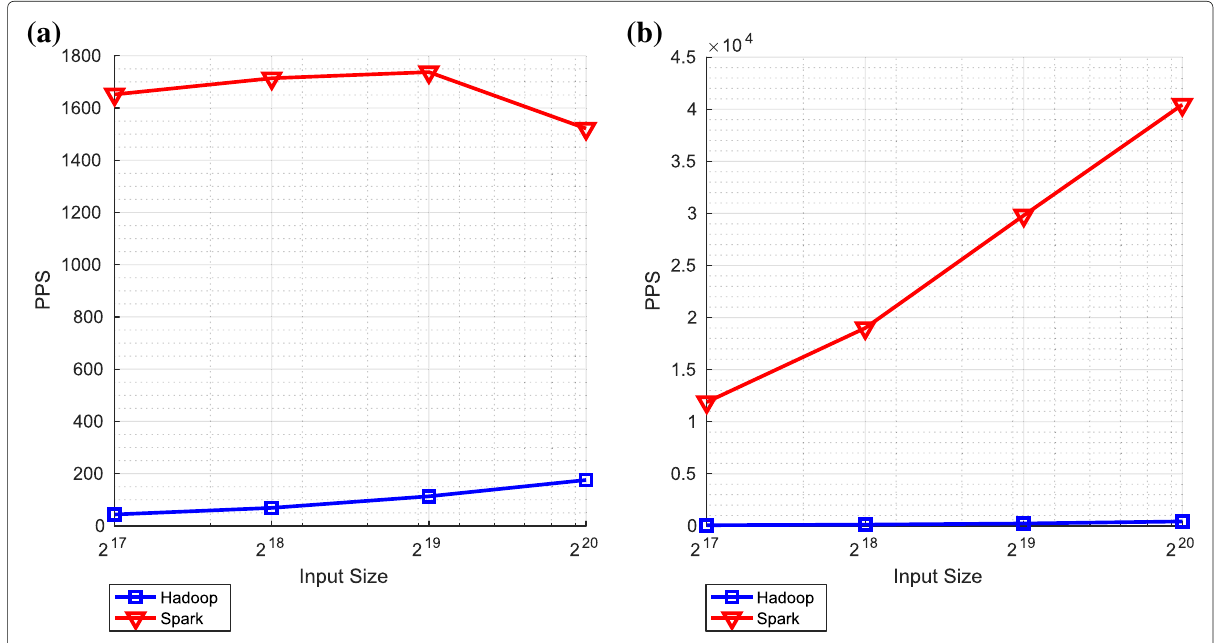
Fig. 10 Bitonic sort and minimum variance resampling on Spark and Hadoop. a Bitonic sort. b Minimum variance